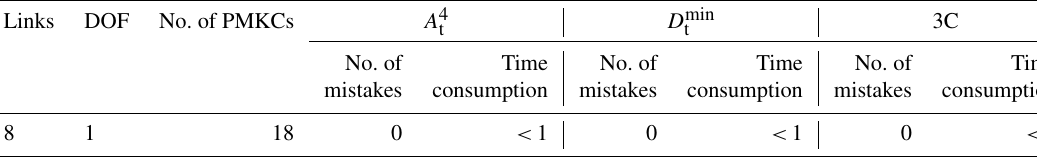
Table 2. Detection results of PMKCs.